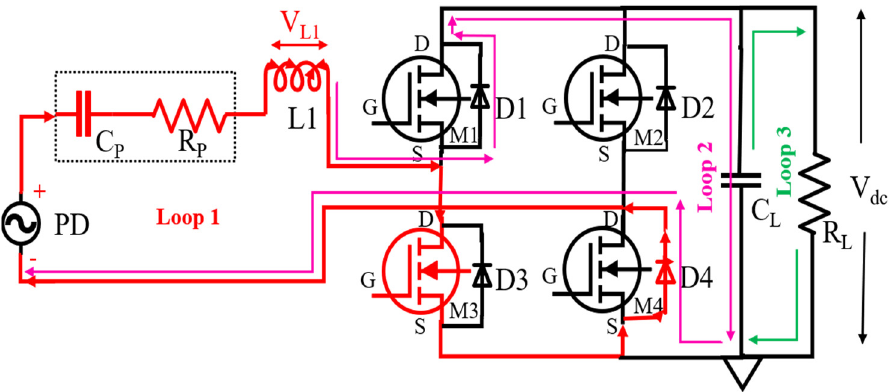
Figure 7. The operation loops in the positive half cycle.